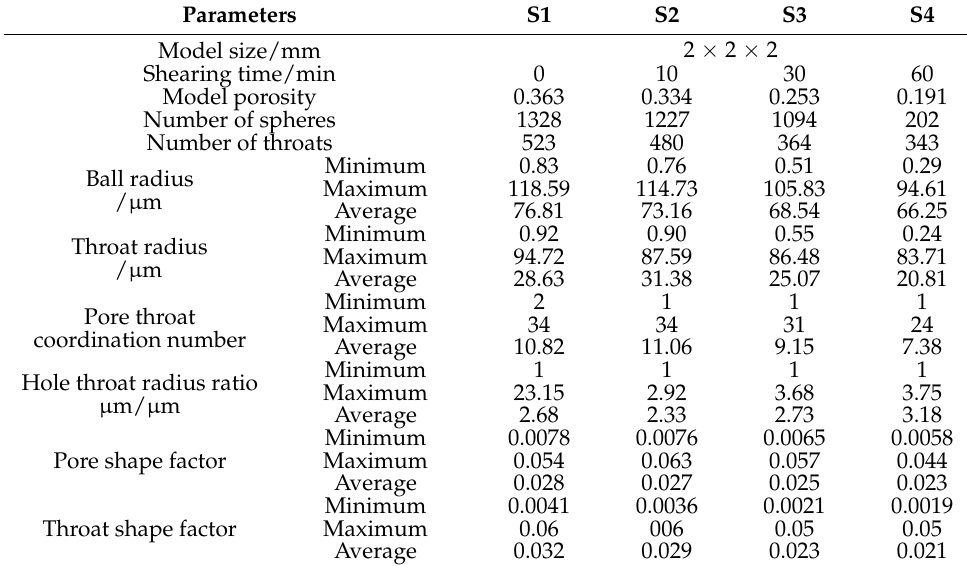
Table 3. Statistical table of hole throat size data.